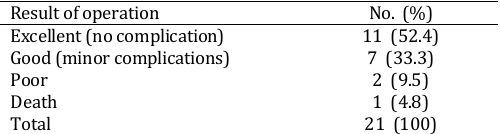
Table 2. Results of the operations on the patients with post- intubation TEF in Massih Daneshvari Hospital during 2004-2013 Result of operation